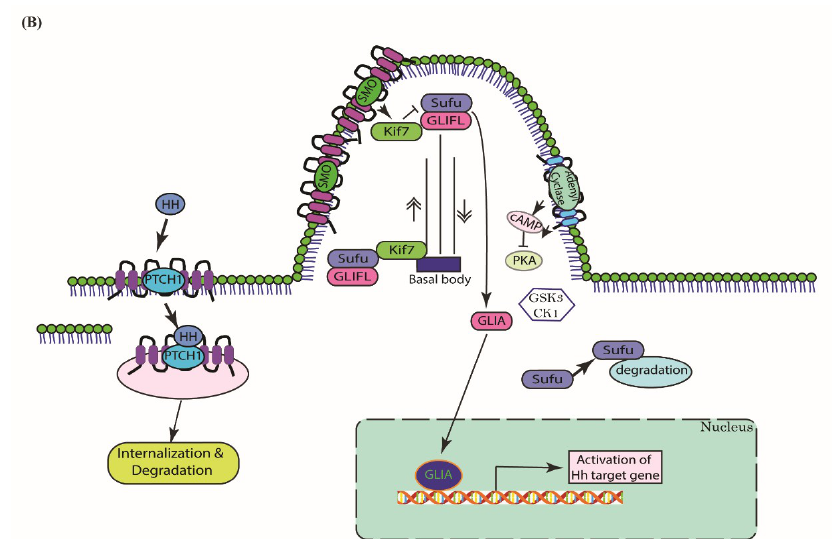
Figure 1. Schematic representation of the mammalian canonical Hh signaling pathway. ( A ) In the absence of Hh, PTCH1 localizes in the cilia and thus prevents the membrane localization and activation of SMO. SMO then internalizes in the membrane of intracellular endosomes and degrades. The full-length GLI (GLIFL) is modified by protein kinases protein kinase A (PKA), glycogen synthase kinase-3 (GSK3), casein kinase 1 (CK1), and the E3 ubiquitin ligase β-TrCP, which is then proteolytically cleaved into the transcriptional repressor form GLIR. The active form of GLI (GLIA) is suppressed by SUFU. After that, GLIR translocates to the nucleus and inhibits the expression of its target genes. ( B ) Binding of Hh to PTCH1 results in its internalization as well as the ciliary translocation and activation of SMO. GLIFL maintains its full length and bypasses the phosphorylation by PKA, GSK3, and CK1, which leads to the formation of activated GLI (GLIA). GLIA then translocates to the nucleus where it induces the expression of Hh target genes. Interestingly, Kif7 not only participates in the movement of GLIFL within the cilia but also inhibits Sufu which usually suppresses the formation of GLIA from